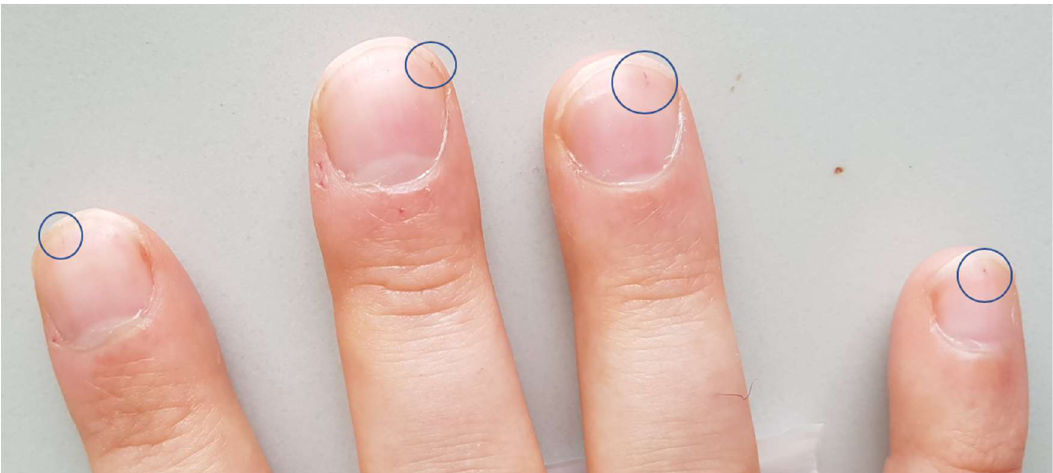
Figure 1. Clinical symptoms. Splinter hemorrhages discretely visible on the nails of the right hand (circles) were one of the first symptoms presented by the patient.